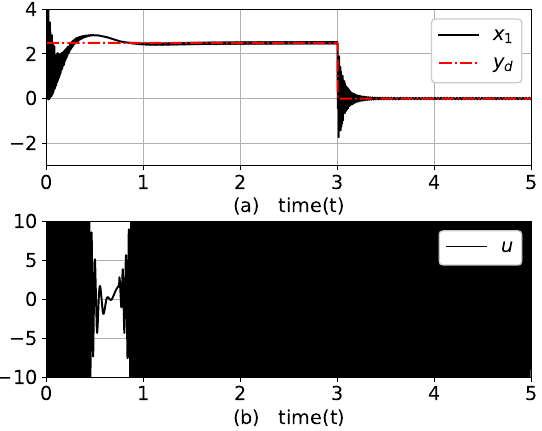
Figure 18. For HOSMD: ( a ) y , y d , and ( b ) u .